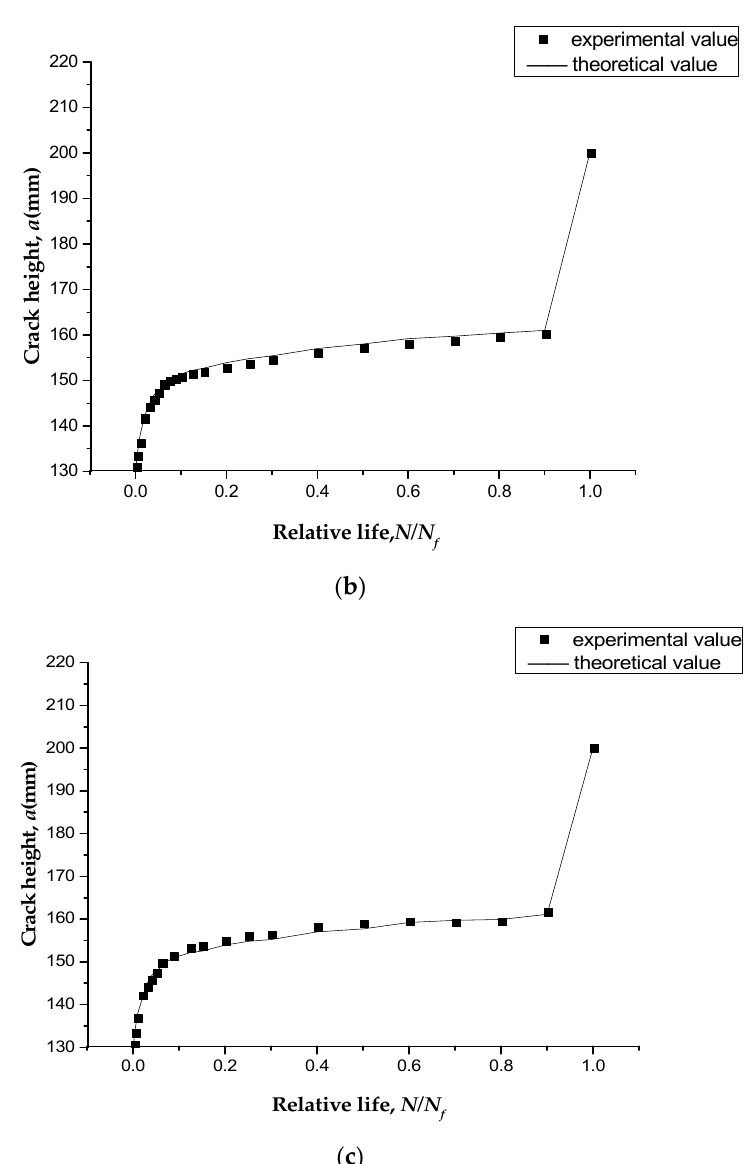
Figure 13. Comparison between a - N curves of experimental data and predicted values. ( a ) P0-30-1; ( b ) P10-30-1; ( c ) P10-40-1.